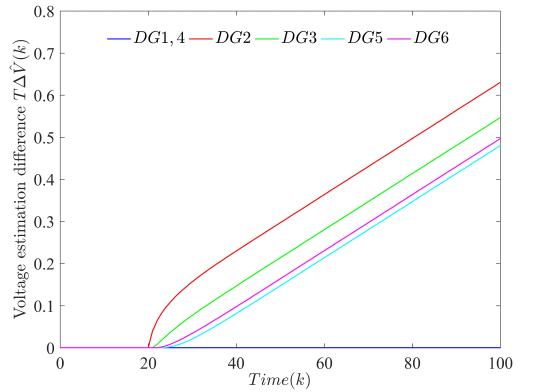
Figure 8. Estimation difference of the DGs using the strategy in [17] under the estimation- dependent